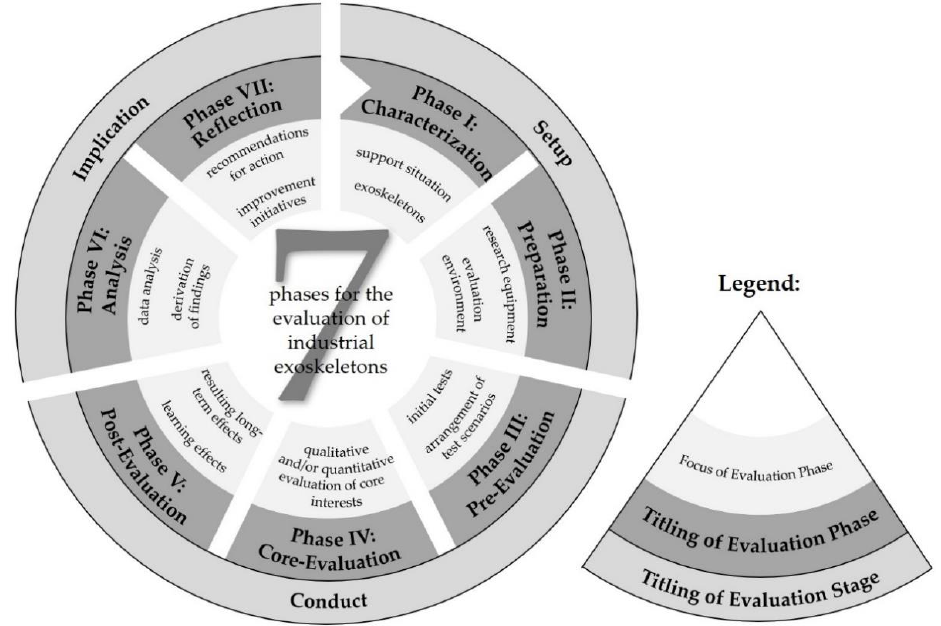
Figure 1. A 7-phase model for the comprehensive evaluation of industrial exoskeletons.